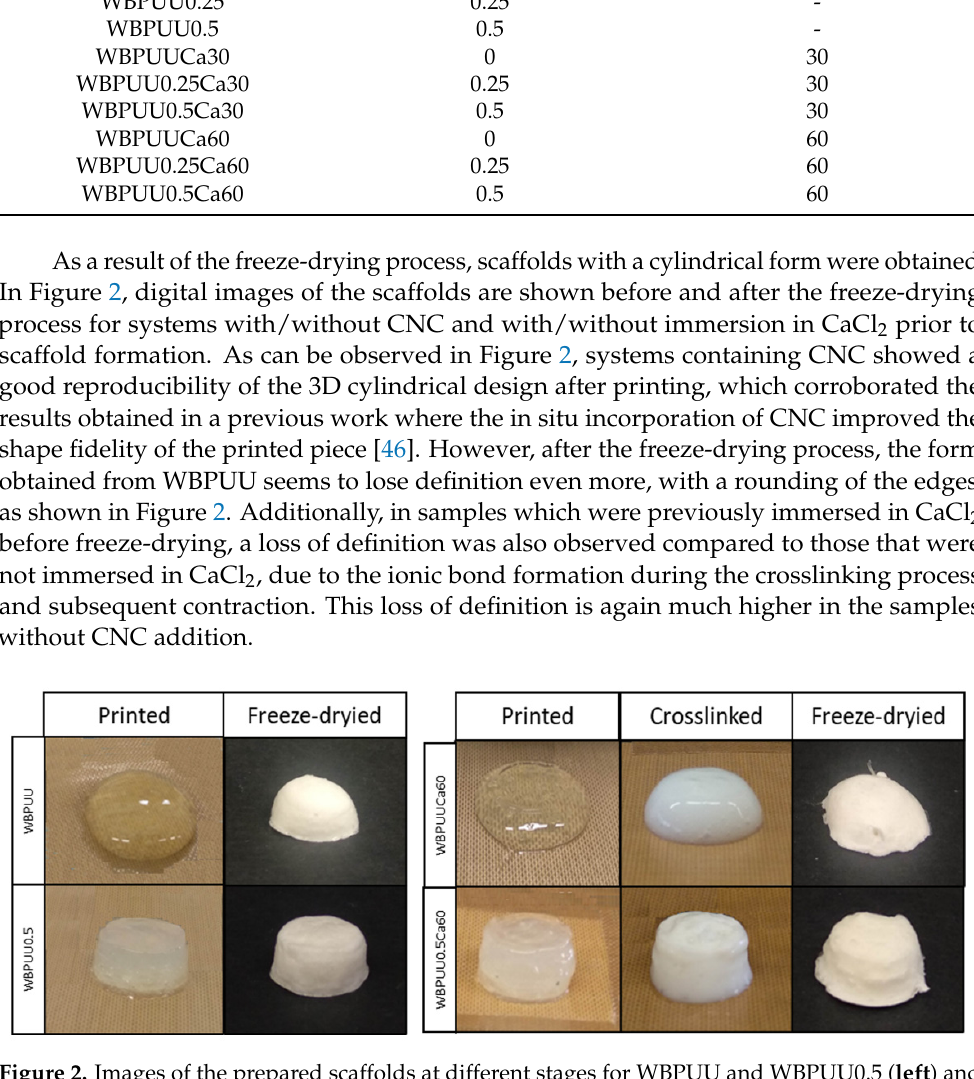
Figure 2. Images of the prepared scaffolds at different stages for WBPUU and WBPUU0.5 ( left ) and WBPUUCa60 and WBPUU0.5Ca60 ( right